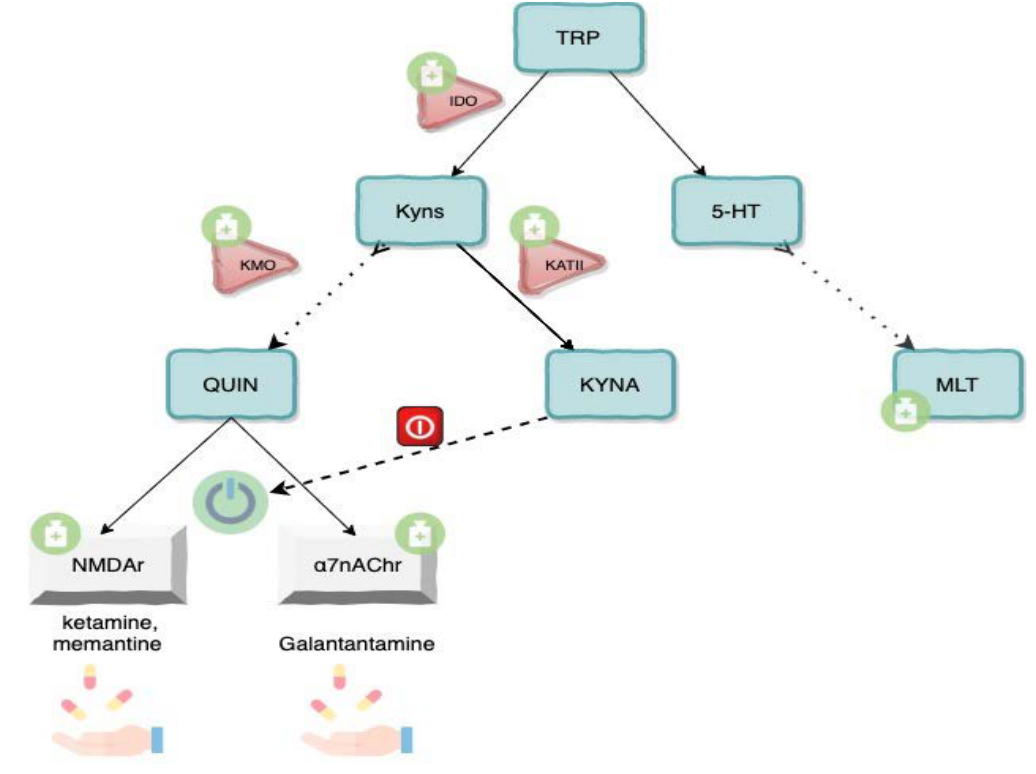
Figure 4. Therapeutic targeting of